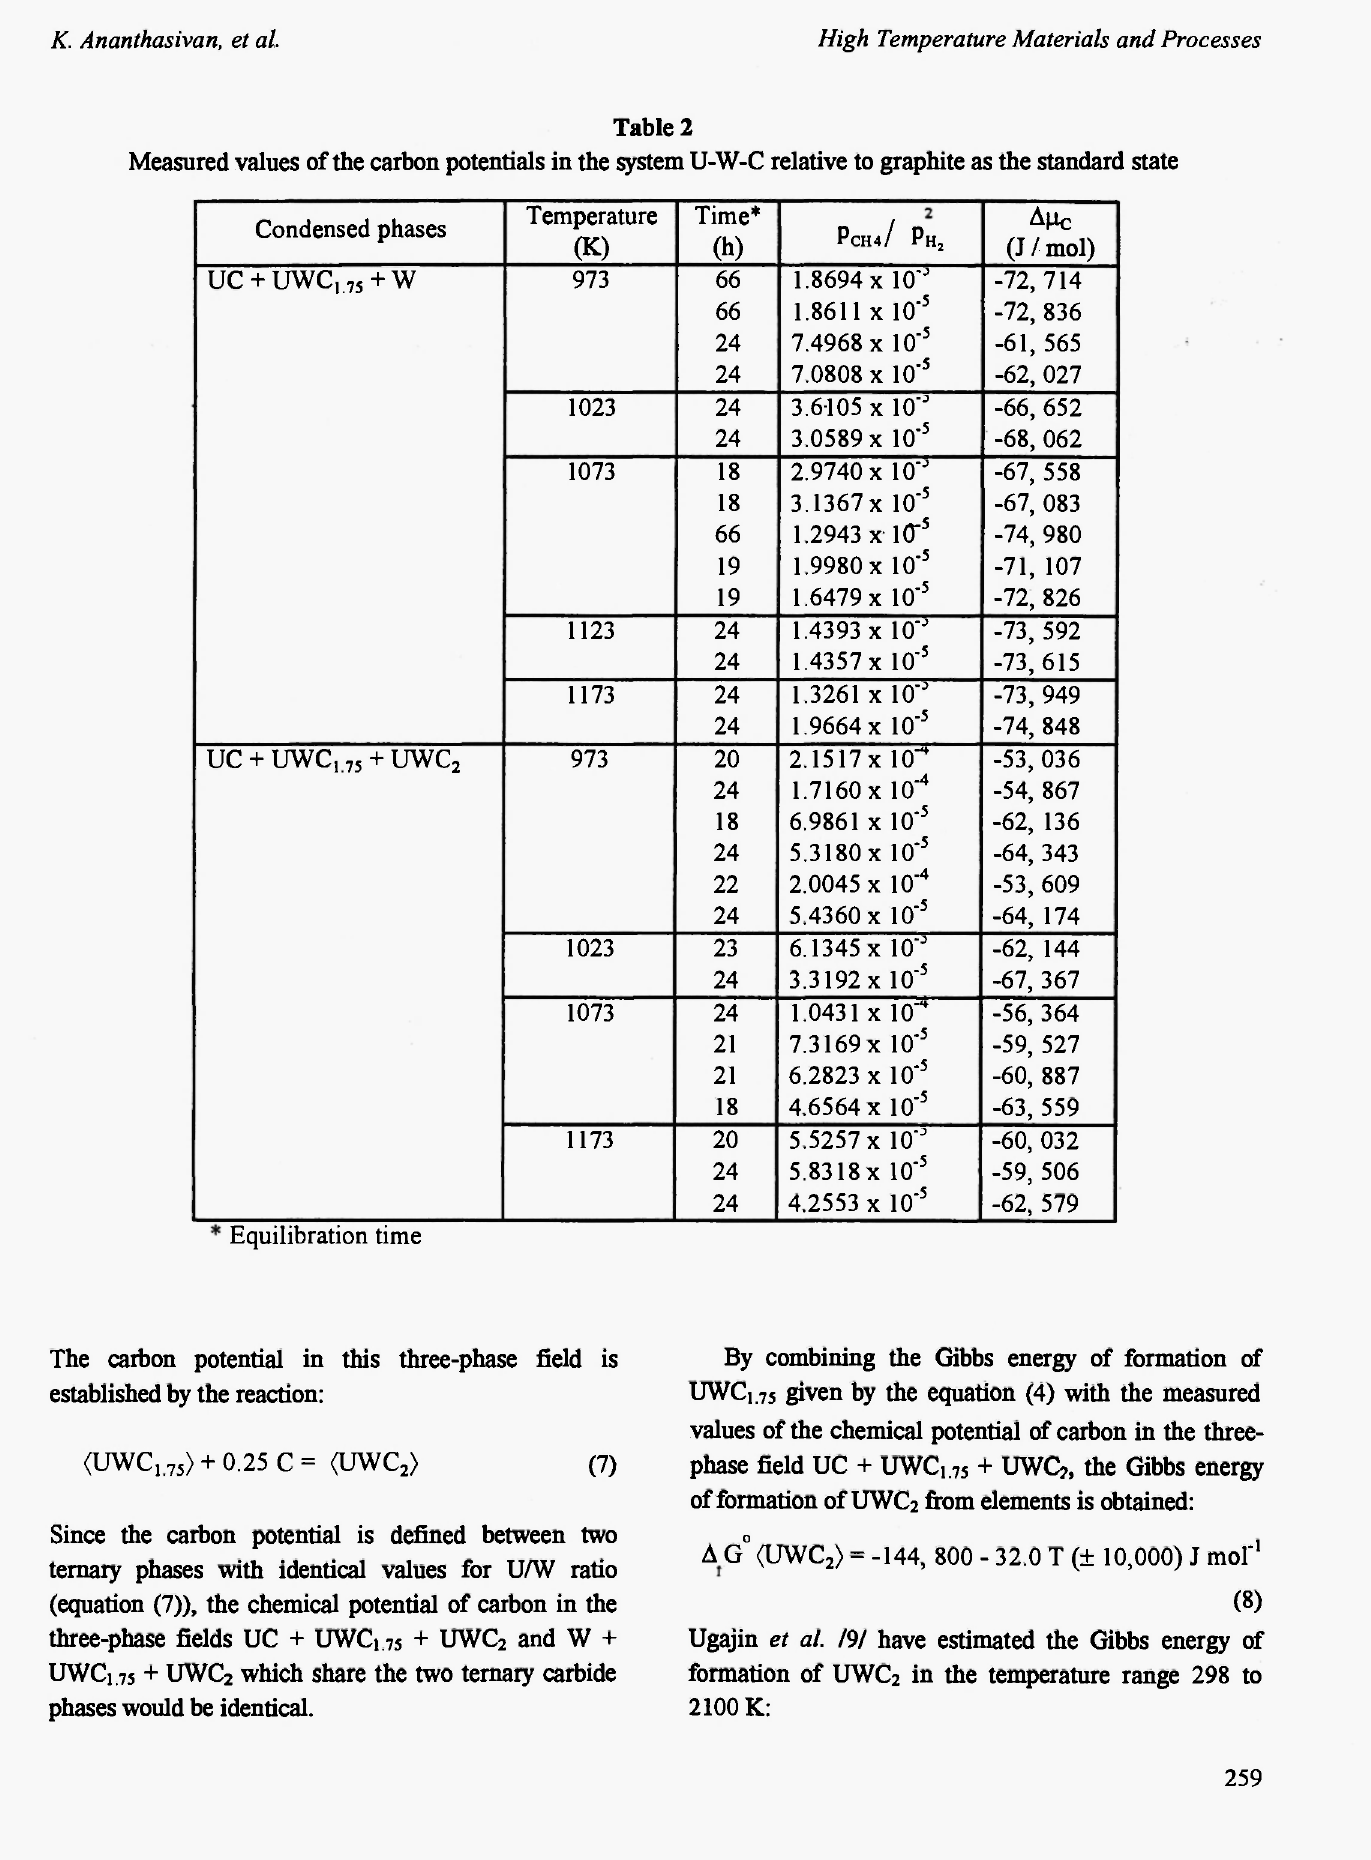
Measured values of the carbon potentials in the system U-W-C relative to graphite as the standard